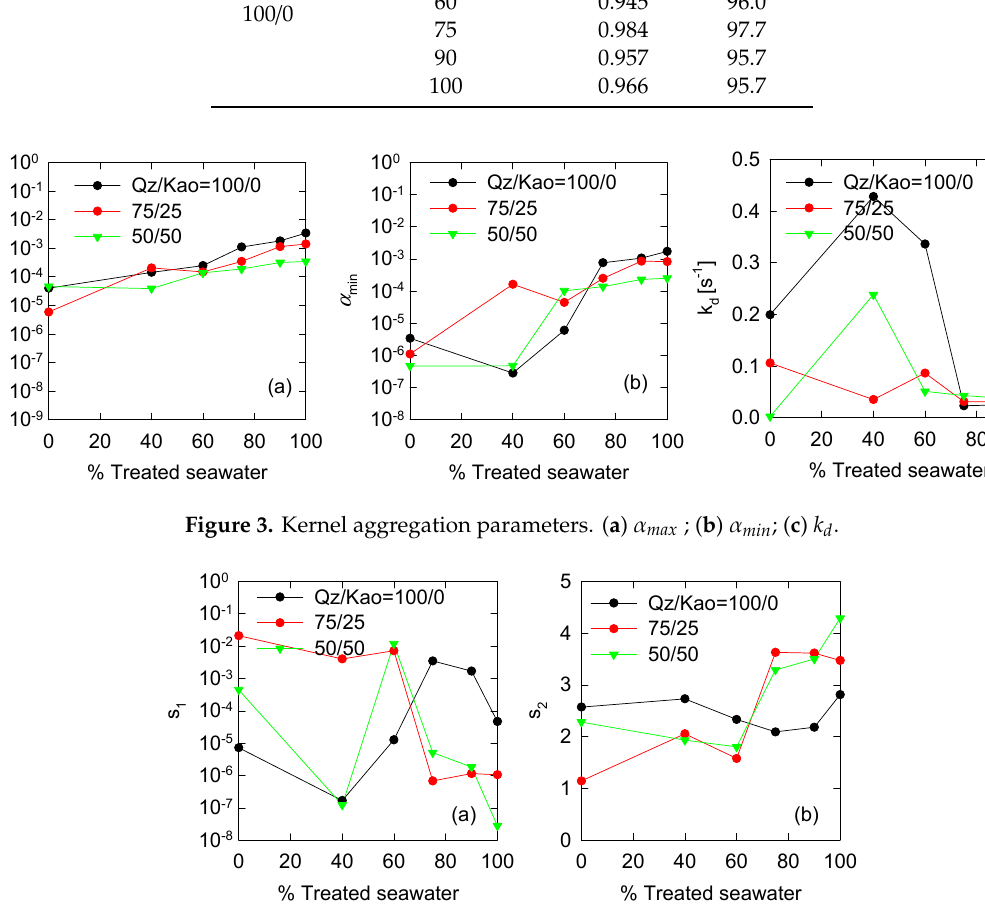
Figure 4. Kernel beakage parameters. ( a ) s 1 ; ( b ) s 2 .